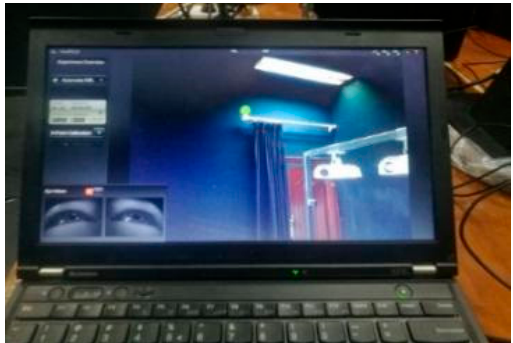
Figure 3. Eye-tracking device commissioning.